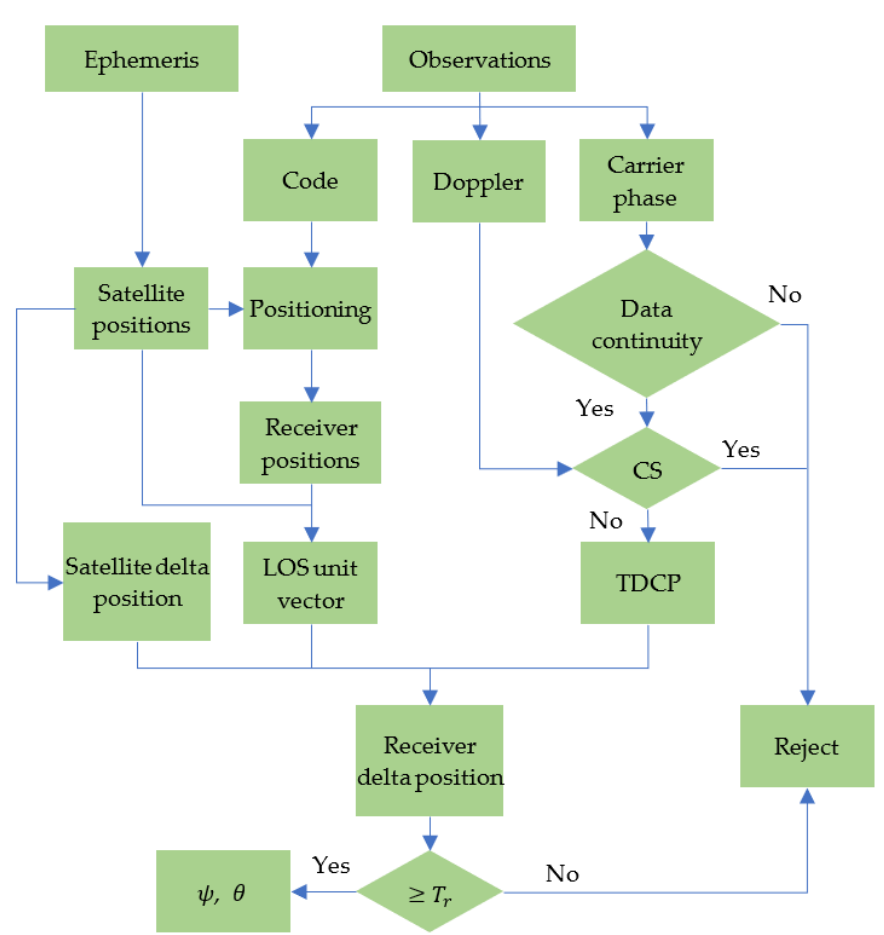
Figure 1. Flow diagram of the proposed vehicular heading and pitch angle estimation algorithm.